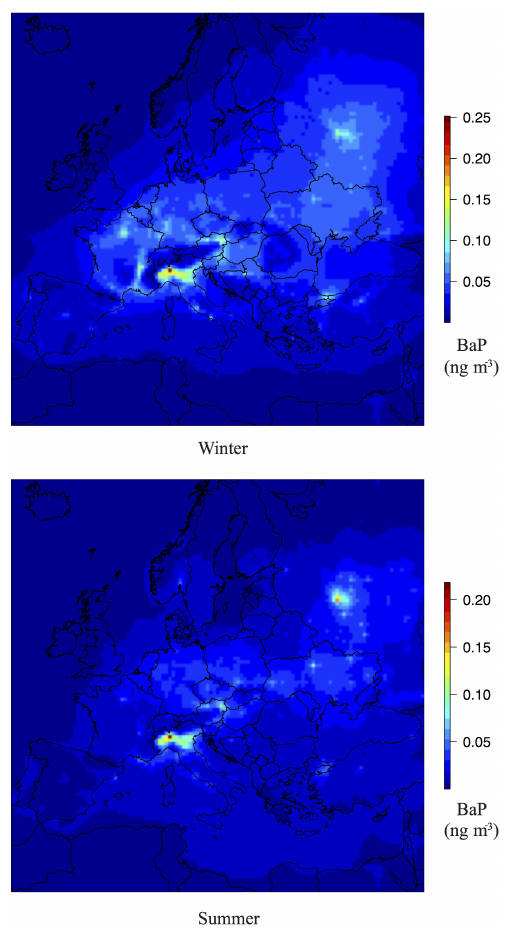
Figure 5. Average difference of surface-level BaP concentrations (ngm − 3 ) between scenario 4 and the fully expanded GPP sce- nario 5, which includes the heterogeneous reaction with ozone dur- ing the winter and summer months of 2006 (scenario 4–scenario